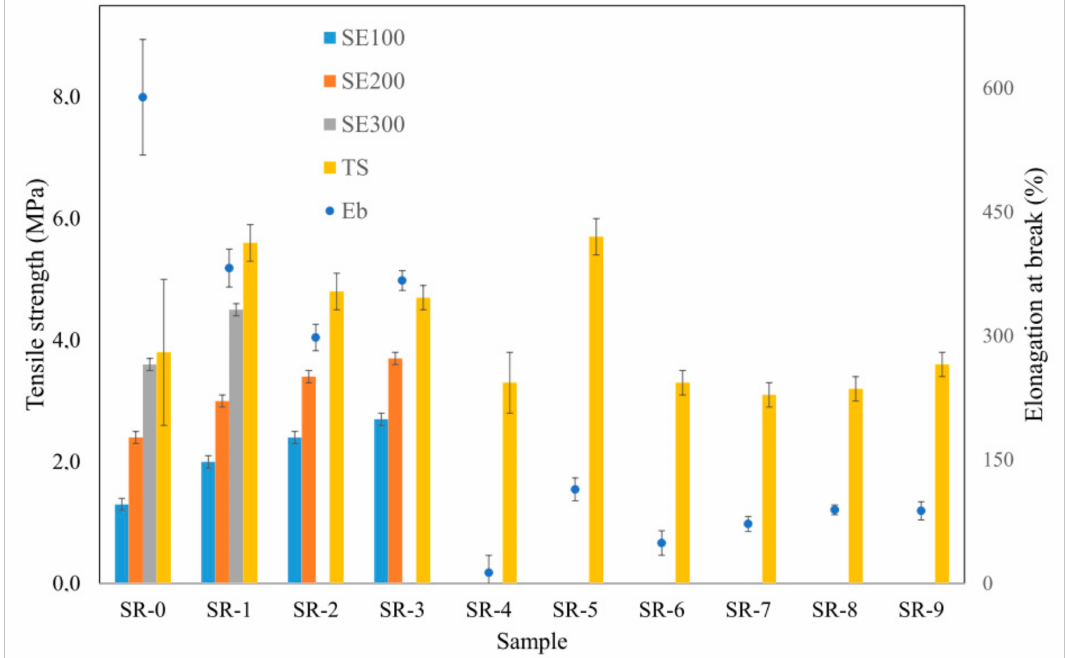
Figure 18. Mechanical properties of the studied